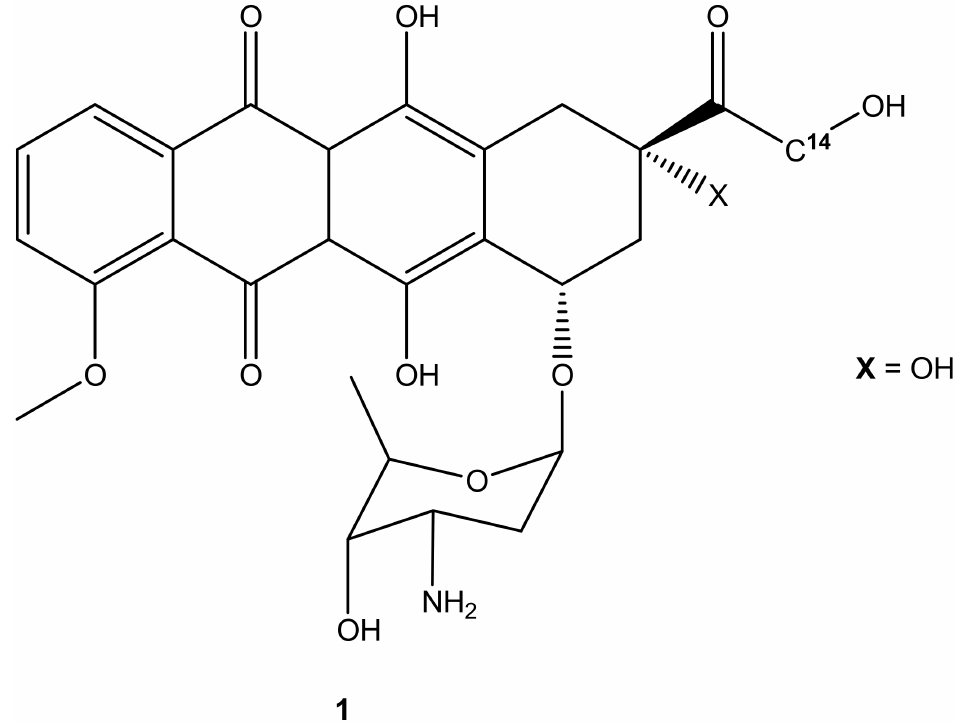
Figure 1. Chemical structure of doxorubicin ( 1